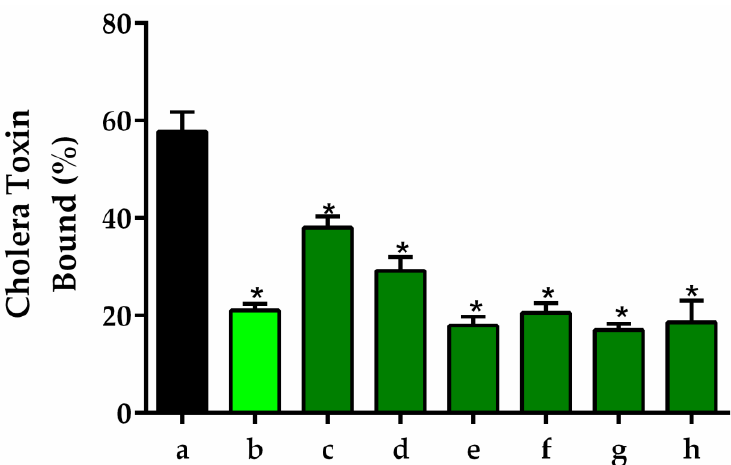
Figure 7. Effects of RAG on cholera toxin (CT) and GM1 binding. CT (100 ng) was incubated alone (column a) or with 1, 10, 50, 100, 300, or 500, µg/mL of RAG (columns c to h, respectively), and the amount of CT was estimated by GM1 ELISA. GM1-coated wells were preincubated with RAG and washed, and then 100 ng of CT was added to the wells and the amount of CT was estimated by ELISA (column b). Values obtained for 100 ng of CT were taken as 100% binding. Data shown are means ± SEM from three independent experiments performed under similar conditions. *p < 0.001 vs. column